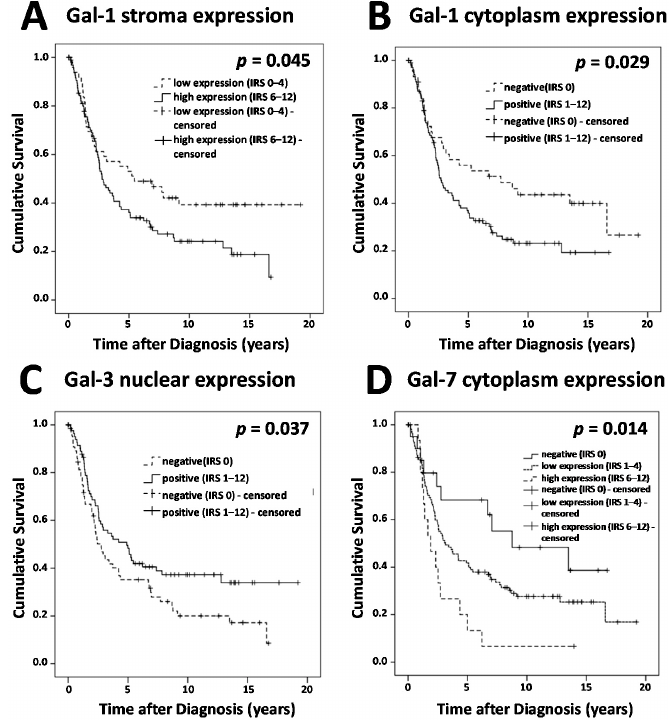
Figure 2. Survival times were plotted as Kaplan-Meier graphs. Percentage of living patients (vertical axis) was plotted in dependence of time (horizontal axis). Patients without an observed event (death) who exited the study before the observation period ended have been censored. Censoring has been marked in the graphs. Survival times of different groups of Galectin expression have been compared. Cases displaying high Gal-1 expression in the stroma showed a significantly reduced outcome compared to cases with low Gal-1 expression in the stroma. ( A ) Cases with Gal-1 expression in the cytoplasm showed significantly reduced overall survival compared to cases without any Gal-1 expression in cytoplasm; ( B ) Cases without Gal-3 expression in nuclei showed significantly reduced overall survival compared to cases with nuclear Gal-3 expression; ( C ) Cases with high Gal-7 expression showed a significantly reduced overall survival and Gal-7 negative cases showed better overall survival, when compared to cases with low expression of Gal-7; ( D ) Galectin expression was determined in cytoplasm, nucleus, and stroma using Remmele (IR) scores.